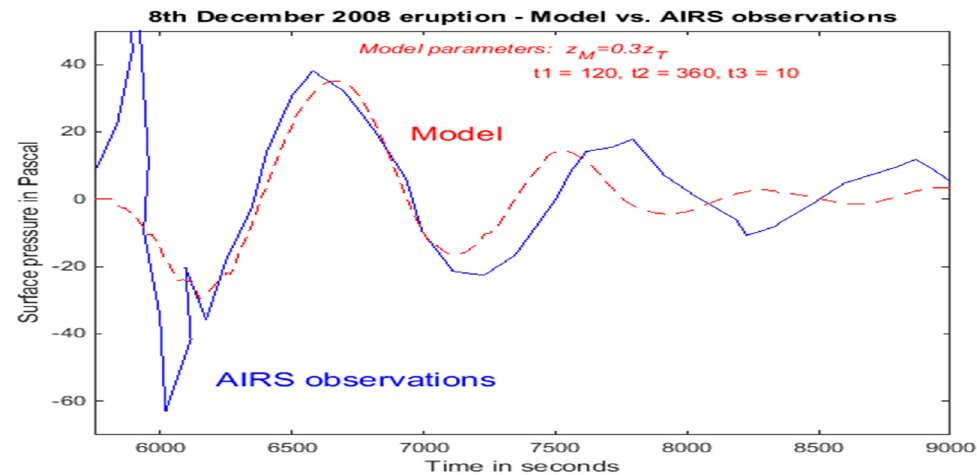
Figure 11. A comparison between observations of surface pressure variations from the eruption on Montserrat on 8 December 2008 at station AIRS (5 km from the source) and a model simulation for these distance. The curves chosen have z M / z T = 0.3, t 1 = 120 s, and t 2 − t 1 = 240 s. This is consistent with an eruption that reached height of 4.2 km, and lasted for 6 min.